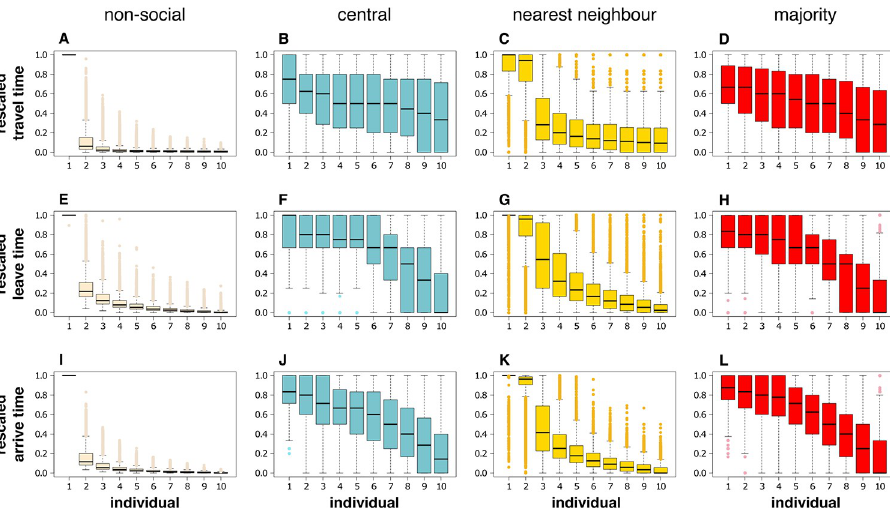
Fig 5. Illustrative examples of mean rescaled individual behaviour. Panels compare non-social individual behaviour and the three social behaviours. Individuals are labelled 1–10, where 1 is the individual with the baseline levels of all parameters, and incremental increases in the label represent the incremental increase by ω difference as described in the methods. This means that when all individuals within a simulation are behaving independently (non-socially), individual 1 is the least likely to start moving towards the feeding site (the shyest), and individual 10 is the most likely (the boldest). Panels A - D show rescaled travel times, where 0 is the travel time of the individual who reaches the feeding site in the shortest time, and 1 is for the individual who takes the longest; E - H show rescaled leave times (at which an individual first crosses a threshold 10 units away from the start point), and I - L show rescaled arrival times at the feeding site. A , E and I show the behavioural metrics for individuals behaving non-socially (independently) within a simulation; B , F and J show the metrics for individuals using the central social rule; C , G and K show the metrics for individuals using the nearest neighbour rule; and D , H and L show the metrics for individuals using the majority rule. All boxplots show the median and interquartile values of the mean rescaled behavioural metric, and the tails show 1.5 × interquartile range, with points representing outliers. Data shown for dataset where ω difference has been systematically altered in order to explore variation in response to this parameter (200 replicates each for ω (0.0001, 0.0002, ... 0.0020), pooling all of these simulations together for each of the figures), with p baseline = 0.001, d food = 100 units and n = 10.